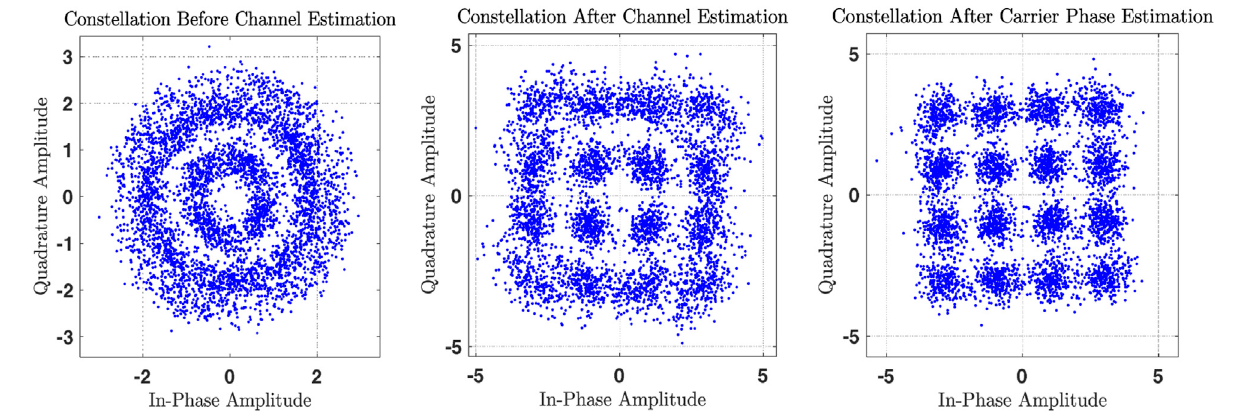
FIGURE 7 | 16-QAM constellation at 110 km SSMF for 120 Gbps data rate.